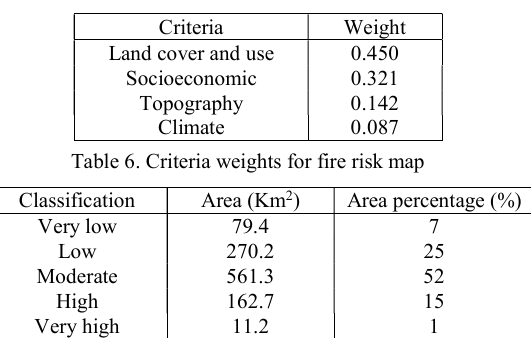
Table 7. Fire risk areas